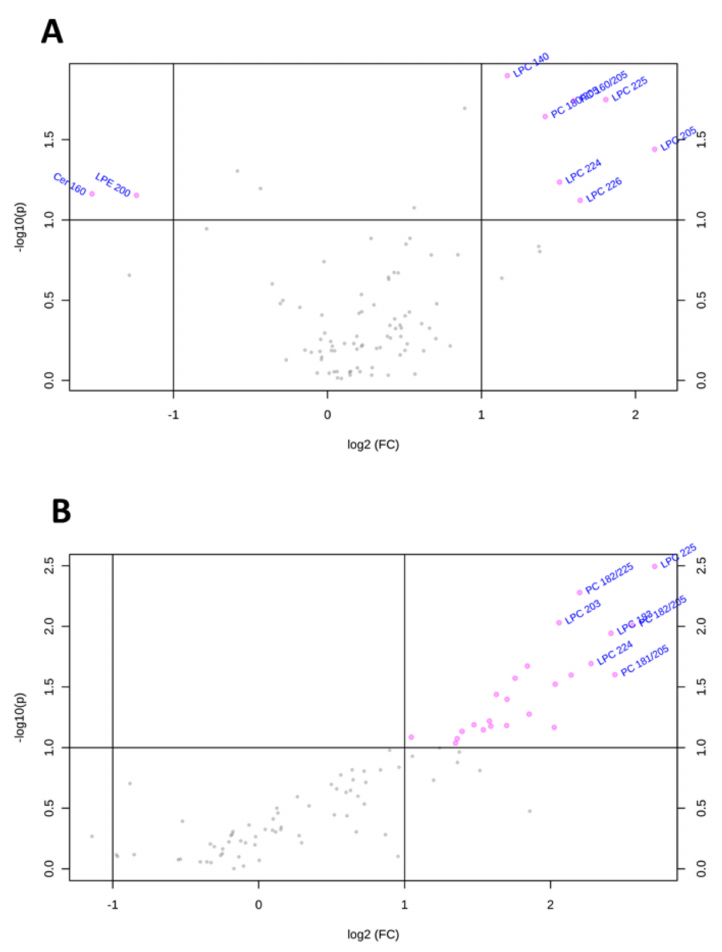
Figure 4. Changes of lipid species in Huh-7 / HepG2 cells depleted for macroH2A1. ( A ) Important features selected by volcano plot with fold change threshold 2 and t-tests threshold 0.1 in KD Huh-7 cells. ( B ) Important features selected by volcano plot with fold change threshold 2 and t-tests threshold 0.1 in KD HepG2 cells. Note both fold changes and p -values are log-transformed. Table 1. Important lipid features in Huh-7 / HepG2 cells depleted for macroH2A1. Lipid Species Fold Change p